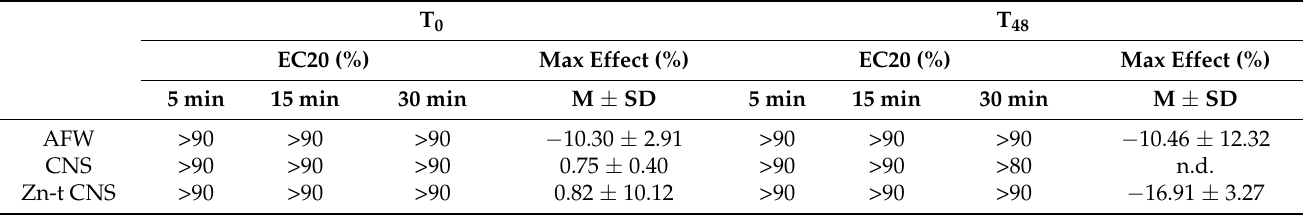
Table 4. EC20 values after 5, 15, and 30 min of incubation and max effects recorded with the Microtox ® system. n.d. not detectable data being Max EC20(T48) after 30 min lower than